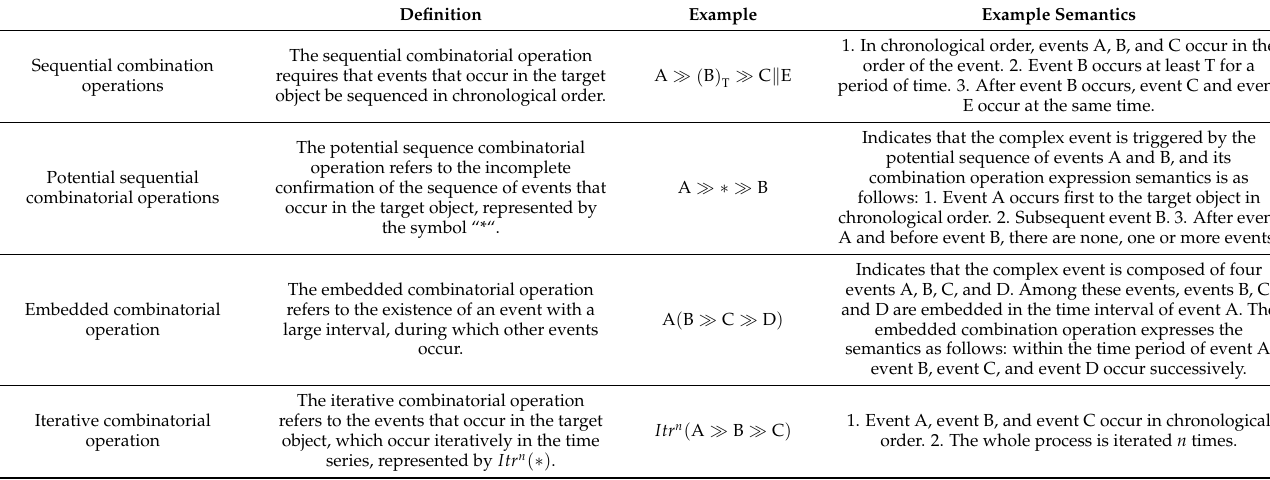
Table A3. Sequential combinatorial